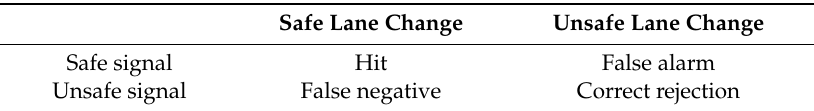
Table 1. The lane-change decision